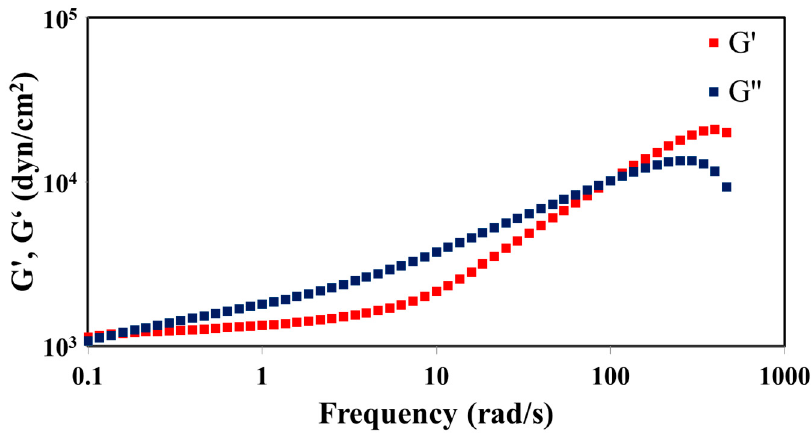
Figure 2. Storage modulus (G’) and loss modulus (G”) of the reaction product of 10:1 mixture.